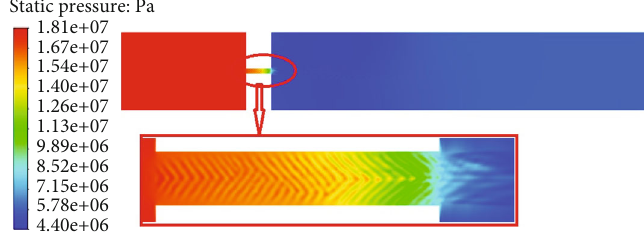
Figure 13: Pressure nephogram and curve of fl ow fi eld in restrictor.